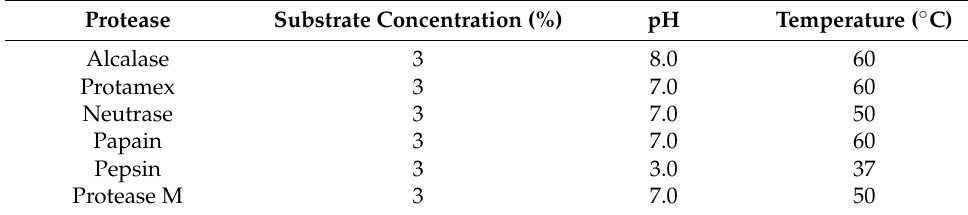
Table 1. Optimum conditions for hydrolysis of α s1 -casein by various proteases.